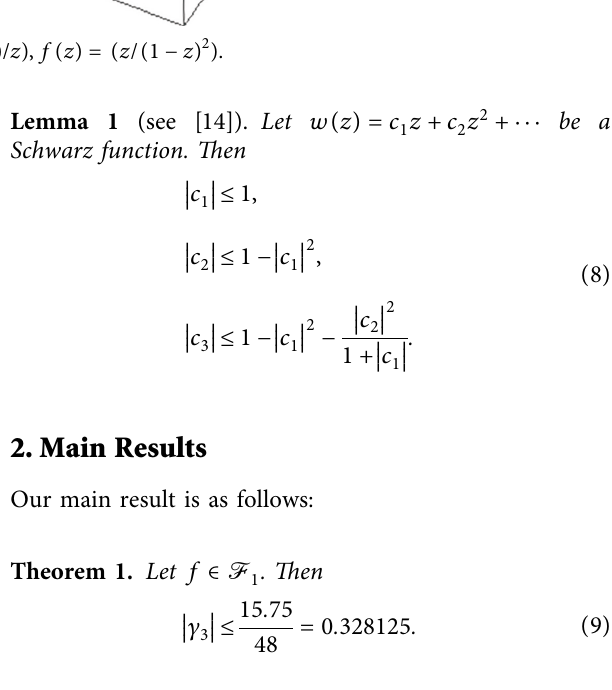
Figure 1: Plot of log